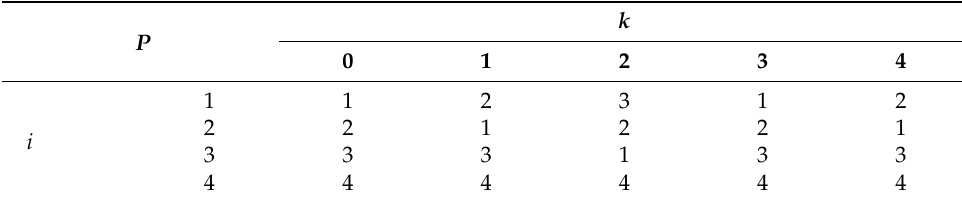
Table 2. A position change matrix P .